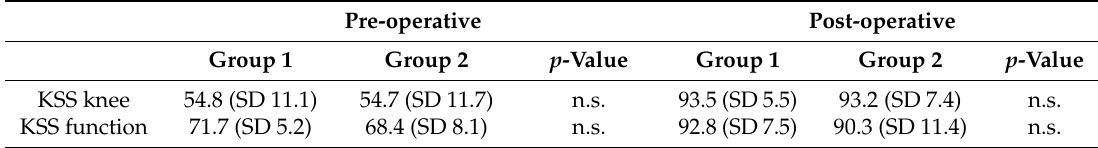
Table 4. Knee Society Score (KSS) values in the pre-operative and post-operative period. Not significant (n.s.)